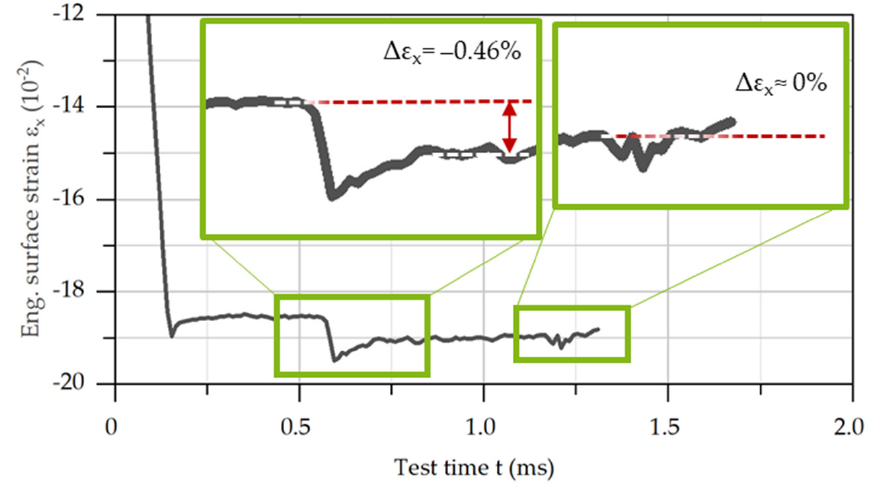
Figure 10. First and second